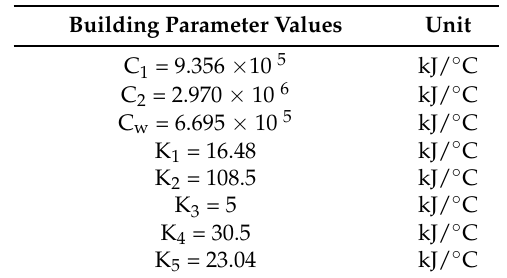
Table 2. Building parameter